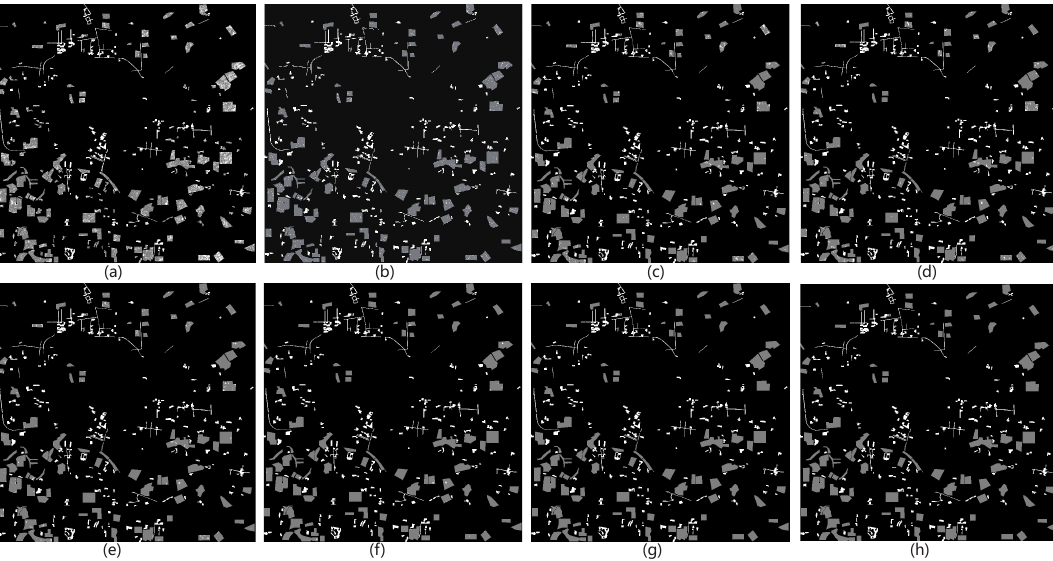
Figure 9. Binary change maps of Kunshan data set. ( a ) CVA. ( b ) IRMAD. ( c ) SCCN. ( d ) S-CNN+Threhold. ( e ) S-CNN+SVM. ( f ) SRDL. ( g ) Our proposed SSJLN. ( h ) Ground truth. The background is black, unchanged samples are gray, and changed samples are